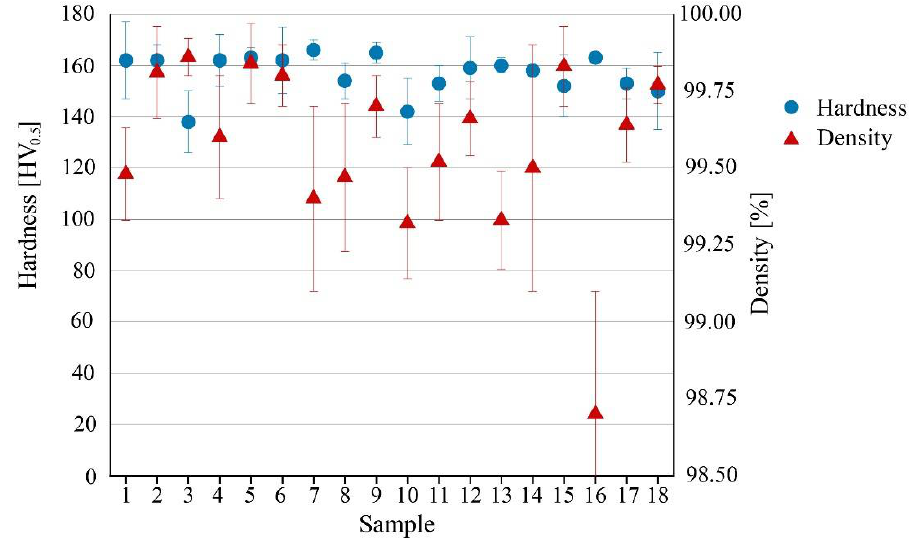
Figure 4. Micro Vickers hardness and density of the 18 samples under analysis.